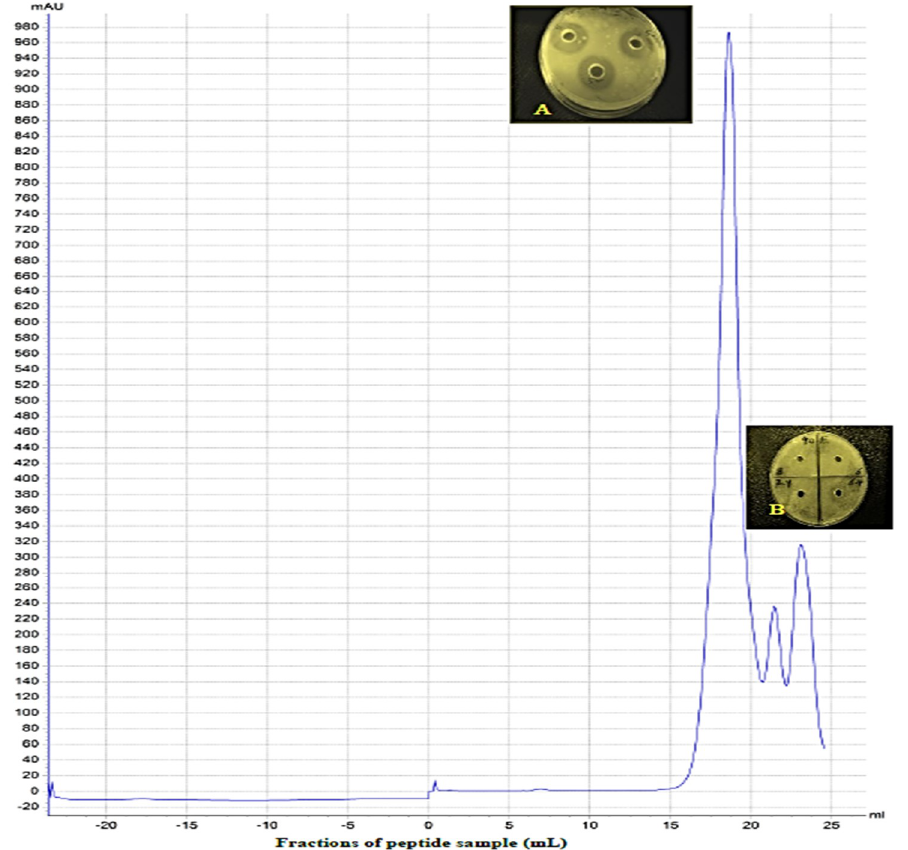
Figure 1. Chromatogram of gel filtration for antibacterial peptides from Saccharomyces cerevisiae by ÄKTA Pure 25 using Superdex 200 10 / 300 GL. ( A ) Inhibition zones of E. coli by peak1, ( B ) non-inhibition zone of E. coli by peak2 and peak3.